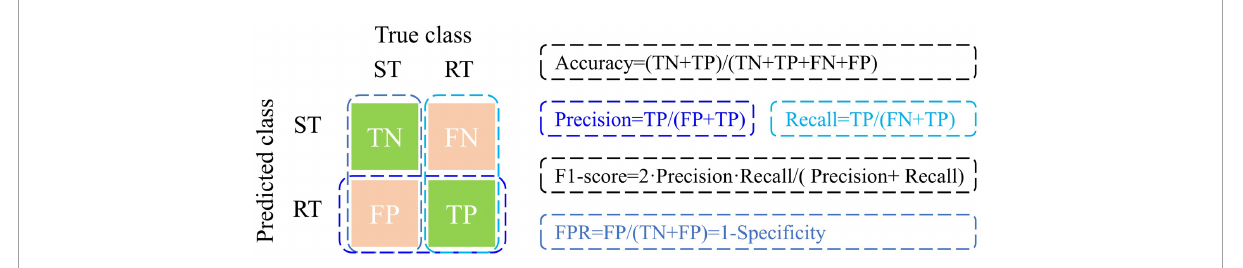
FIGURE3 Confusion matrix and statistic formulas for decision model performance evaluation. RT represents resistant cultivar with glyphosate treated. ST represents sensitive cultivar with glyphosate treated. RT plants and ST plants are set as positives and negatives, respectively. TP, FP, TN, and FN represent the number of true positives, false positives, true negatives, false negatives, respectively. The formulas of model performance evaluation parameters are given on the right side of the picture. False positive rate (FPR) indicates the proportion of negative samples incorrectly